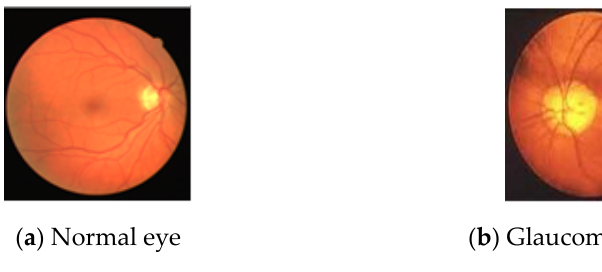
Figure 1. Eye shape (normal and glaucomatous eye).